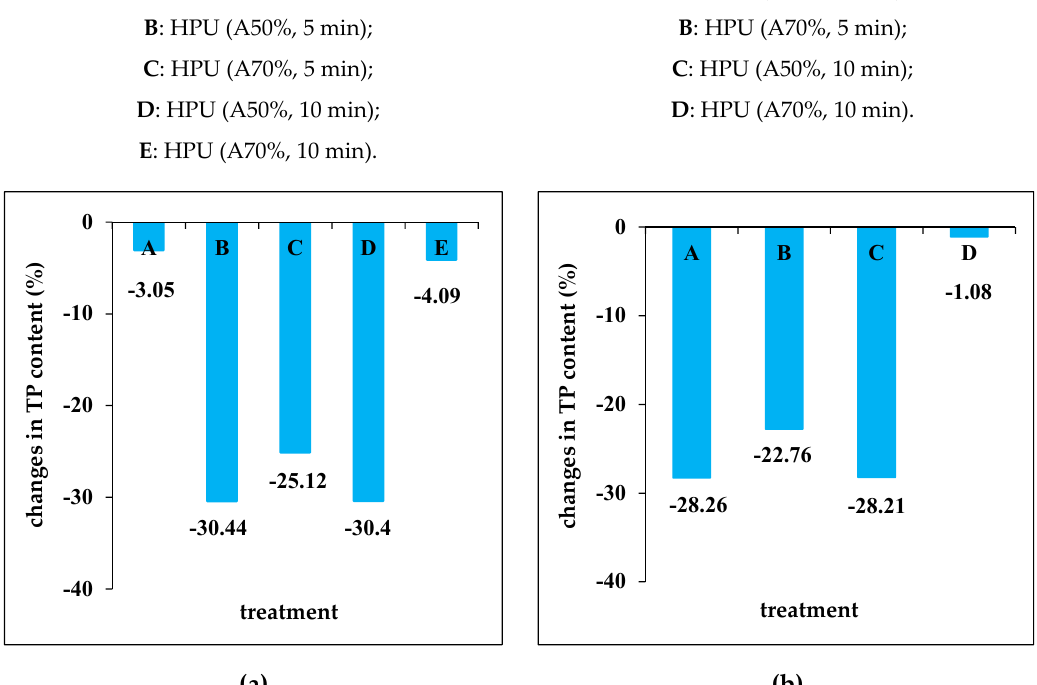
Figure 3. The changes in total phenolic (TP) content of juice samples in response to the applied treatments: ( a ) reported to the control sample (C); ( b ) reported to the pasteurized sample (P).